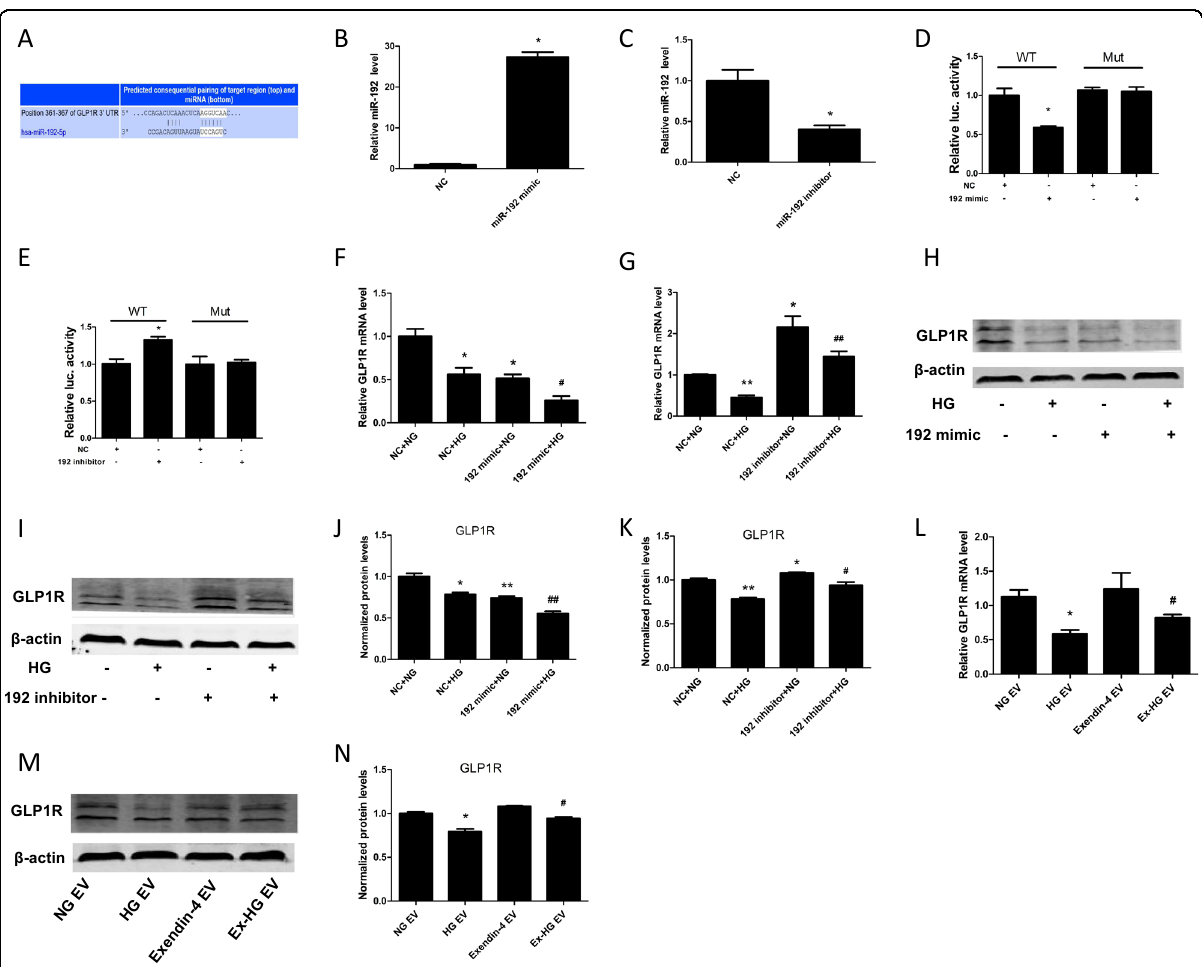
Fig. 6 MiR-192 regulated GLP1R expression. a The predicted miR-192-binding sites within the 3 ′ -UTRs of GLP1R. ( b , c ) Relative expression of miR- 192 in HK-2 cells transfected with miR-192 mimic or inhibitor. d , e Relative luciferase activity in HK-2 cells co-transfected with miR-192 mimic, inhibitor, or NC and pMIR-REPORT containing the GLP1R 3 ′ -UTR site (* P < 0.05 versus the NC group). f , g Relative expression of GLP1R in HK-2 cells transfected with miR-192 mimic or inhibitor and exposed to HG (* P < 0.05 and ** P < 0.01 versus the NC + NG group; # P < 0.05 and ## P < 0.01 versus the NC + HG group). h – k GLP1R expression in HK-2 cells transfected with miR-192 mimic or inhibitor and exposed to HG was analyzed by western blot (* P < 0.05 and ** P < 0.01 versus the NC + NG group; # P < 0.05 and ## P < 0.01 versus the NC + HG group). l – n Relative expression of GLP1R in HK-2 cells after incubation with EVs derived from NG, HG, exendin-4, and Ex-HG groups for 48 h (* P < 0.05 versus the NG EV group; # P < 0.05 versus the HG EV